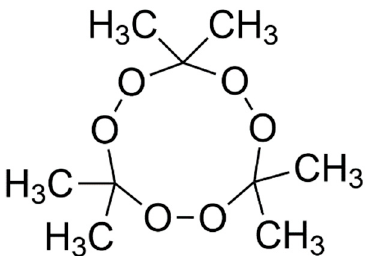
Figure 1. Molecular structure of triacetone triperoxide (TATP), C 9 H 18 O 6 .